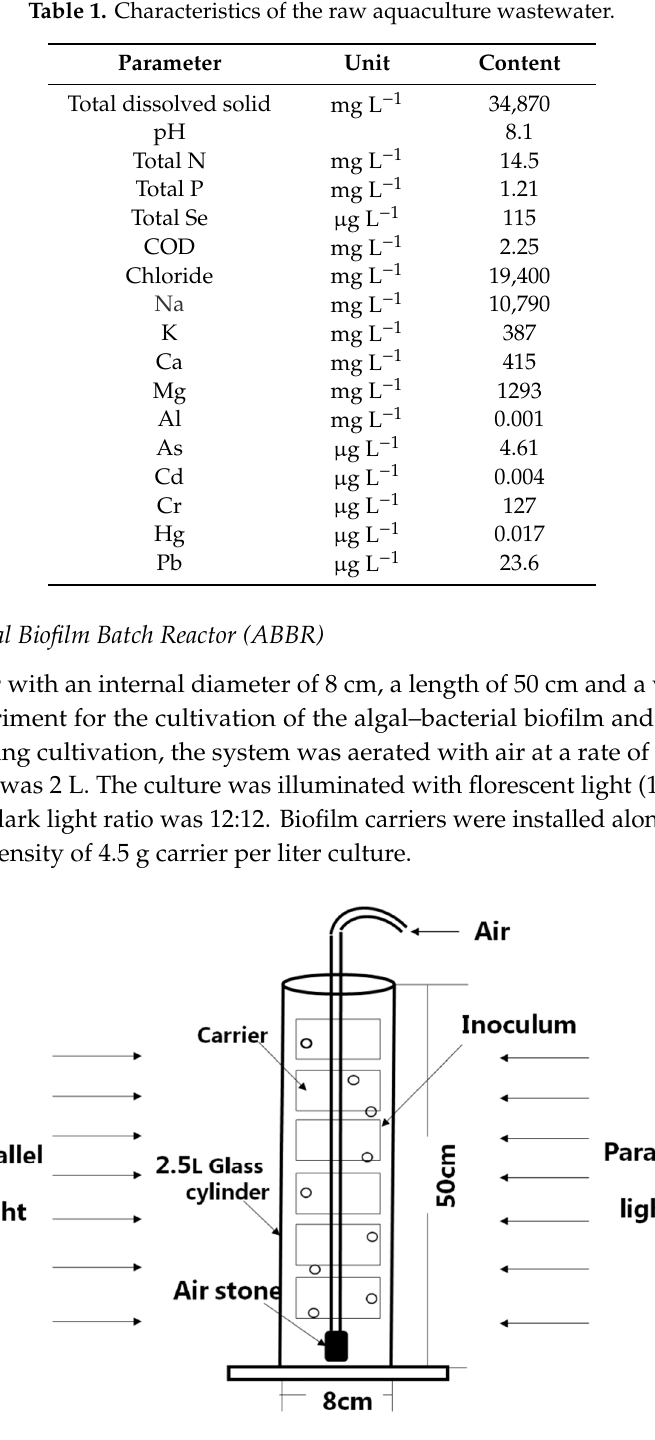
Figure 1. Schematic of algal-bacterial biofilm batch reactor.